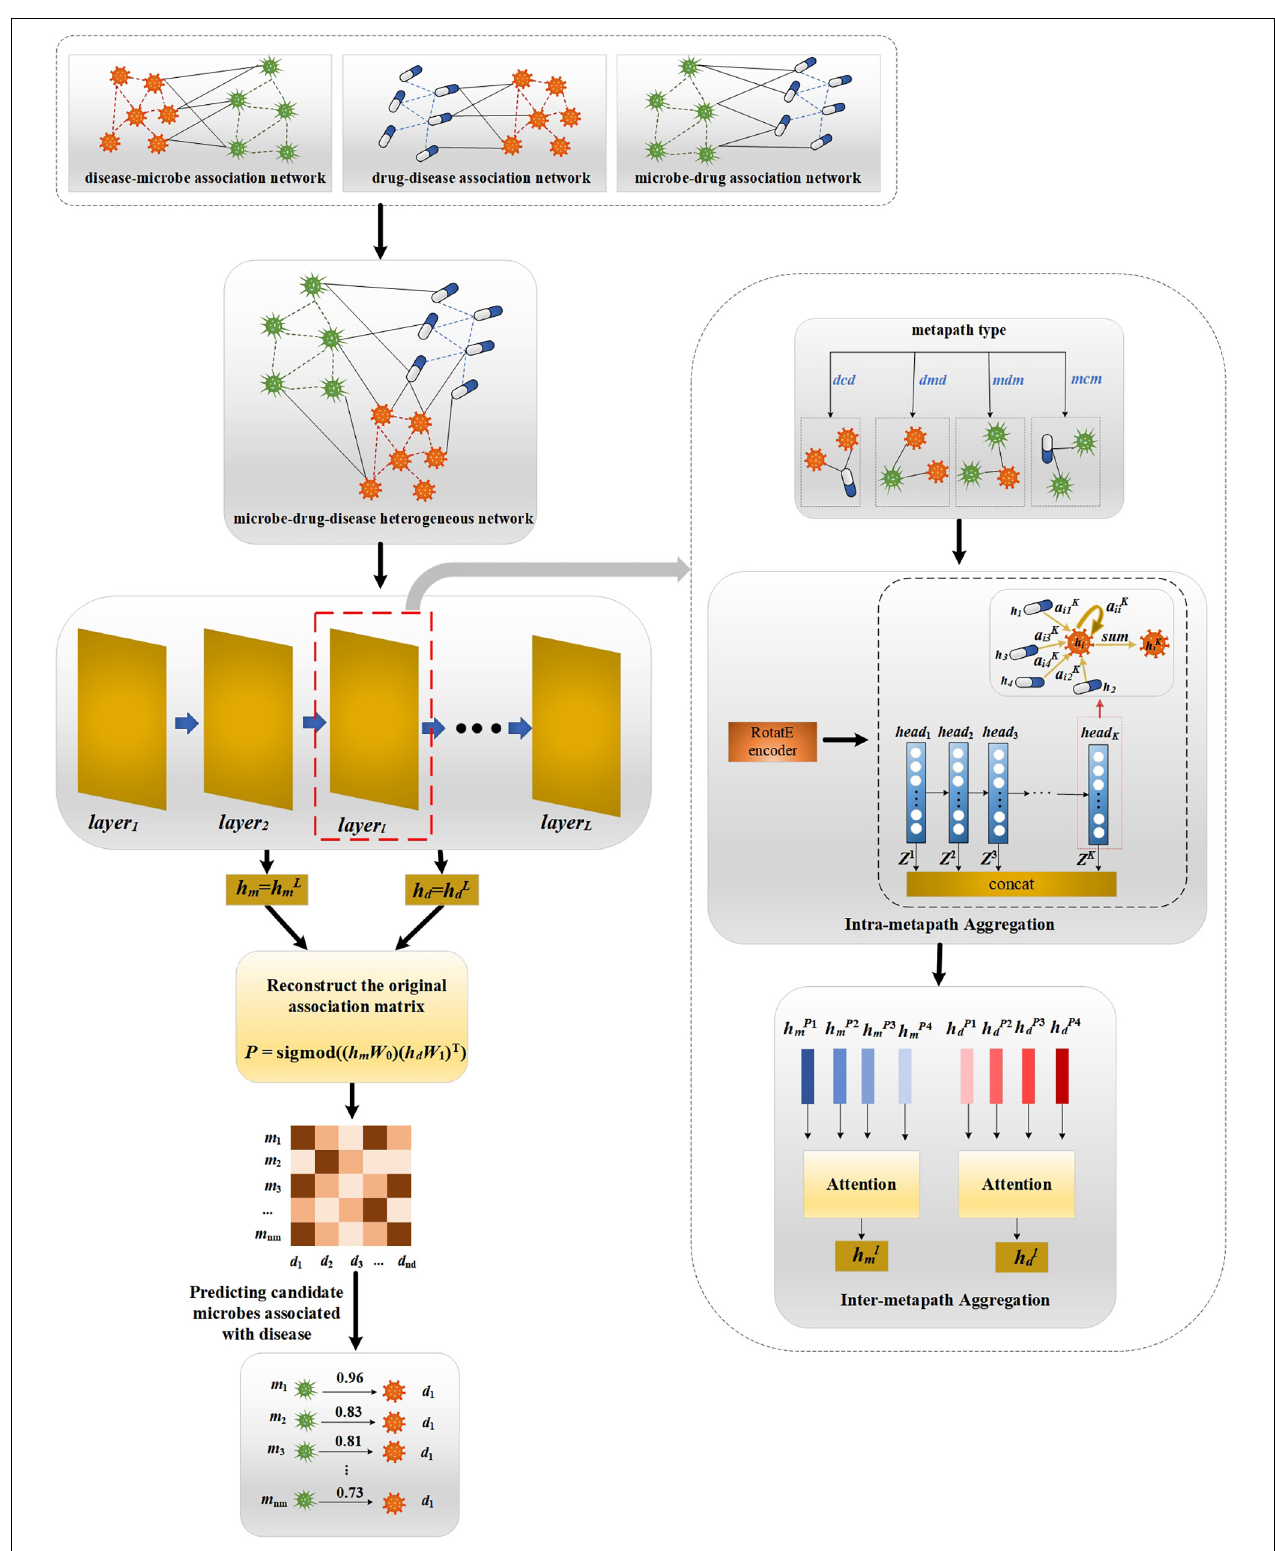
FIGURE 3 | The framework of MATHNMDA. mcm , mdm , dmd, and dcd are four metapaths, where m represents microbe, c represents drug, and d represents disease.